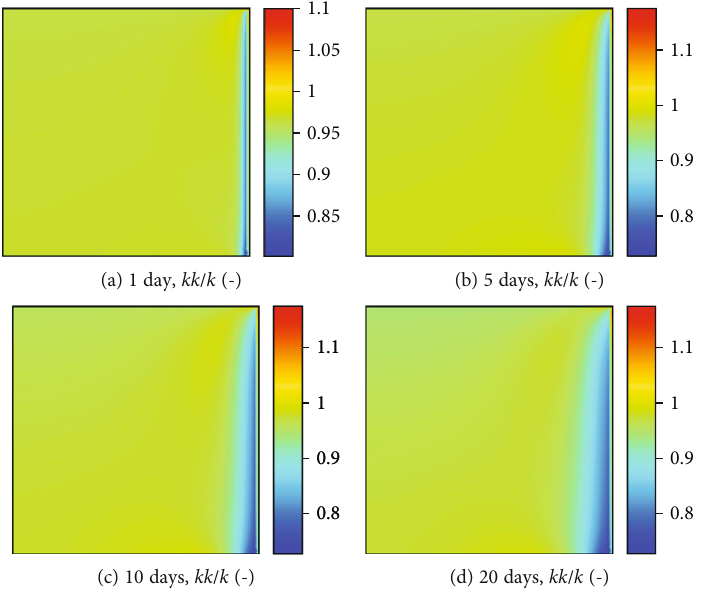
Figure 5: The distributions of permeability ratio at t = 1 , 5, 10, and 20